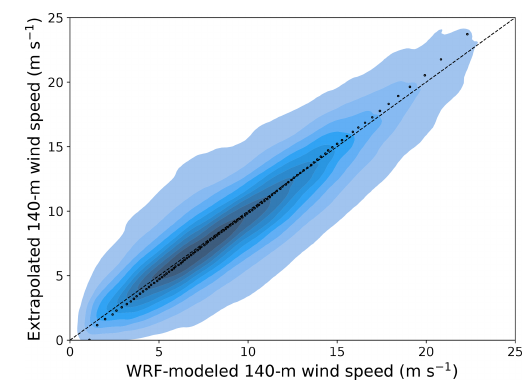
Figure 5. Scatter plot of 21-year WRF-modeled and machine- learning-predicted 140m hourly average wind speed at the loca- tion of the 44025 NDBC buoy. The color shades show density of the data, with darker colors indicating regions with more data. The black dots compare quantiles of the two samples. Table 9. Twenty-year model bias and model uncertainty in 140m wind speed at the location of the NDBC buoys considered in this study. NDBC buoy Bias WRF Total (ms − 1 ) uncertainty uncertainty (ms − 1 ) (ms − 1 ) 44008 0.38